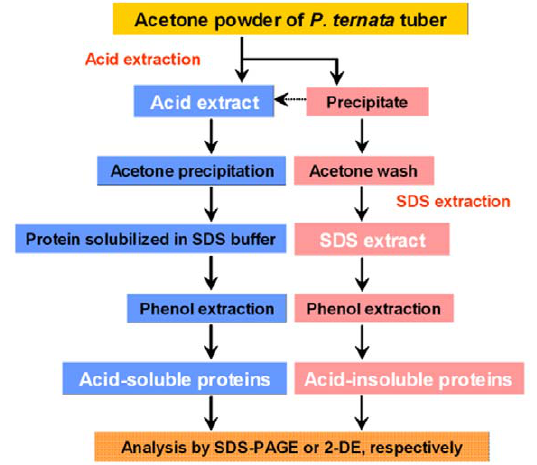
Figure 2. Workflow for sequential protein extraction protocol. Acetone tissue powder of Pinellia ternata tubers was sequentially extracted by 10% acetic acid, followed by SDS-containing buffer.